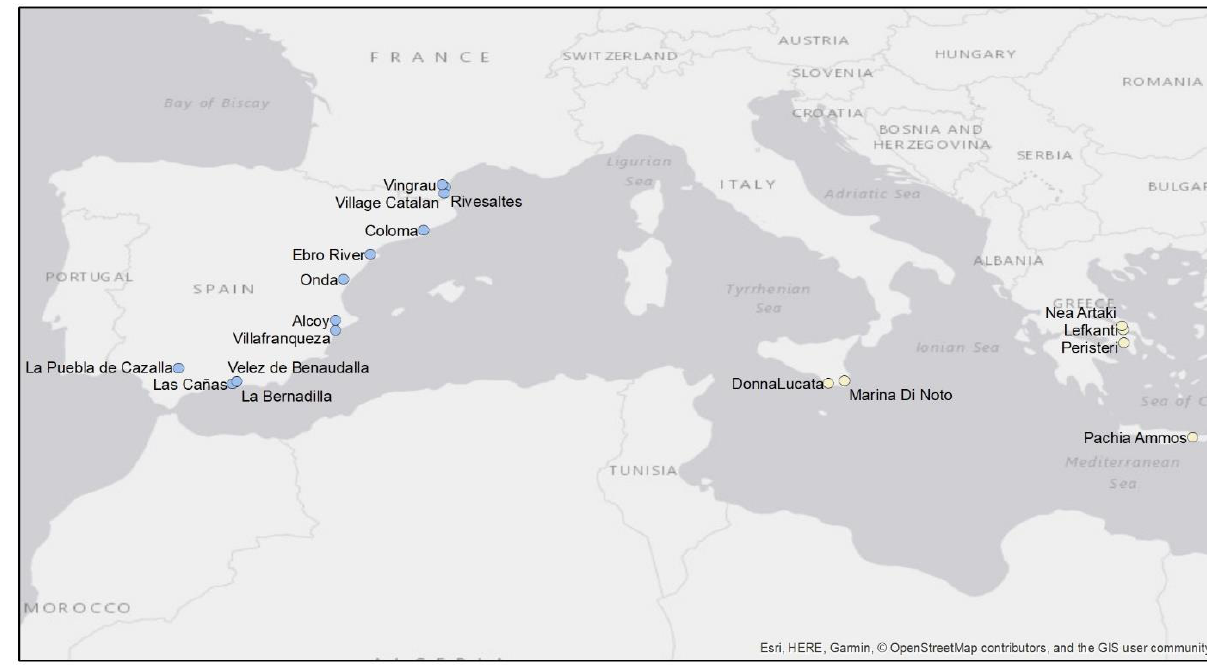
Figure 2. European sites where Rhizaspidiotis donacis specimens were collected between 2007 and 2010 for genetic analysis as part of the Arundo donax biological control program. Locations with the same color represent individuals that display less than 2% genetic distance.